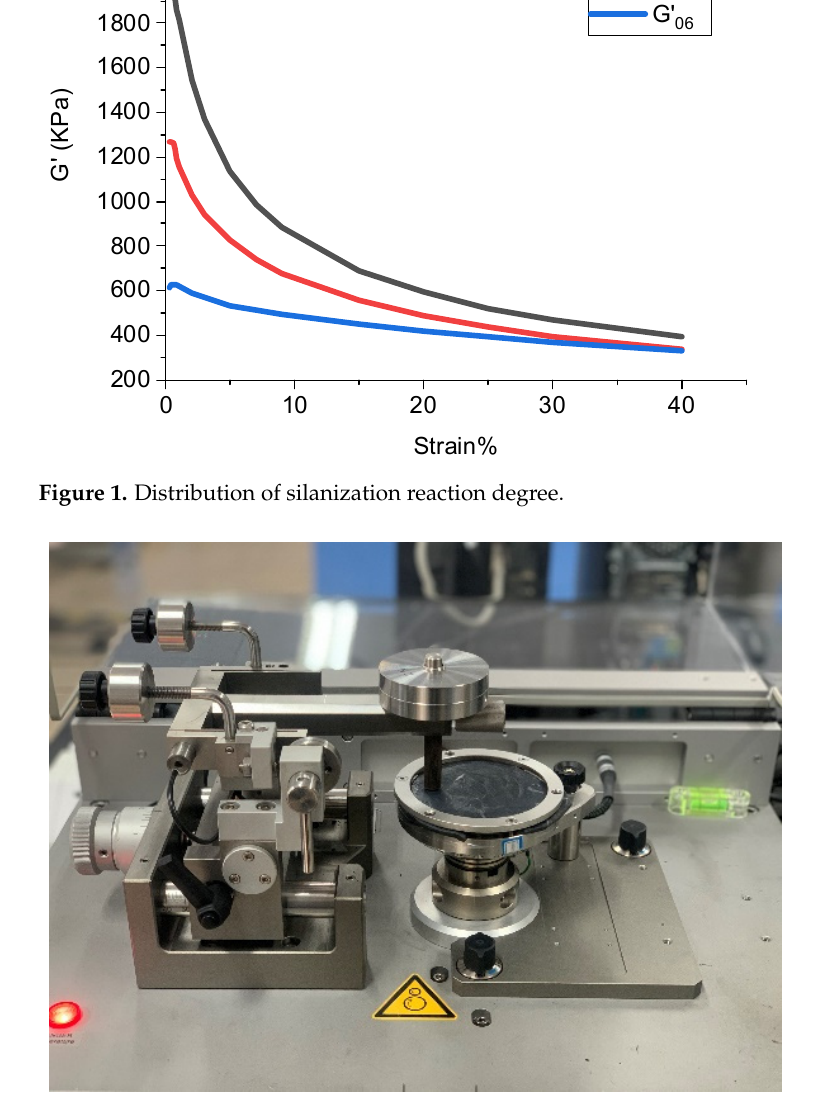
Figure 1. Distribution of silanization reaction degree.